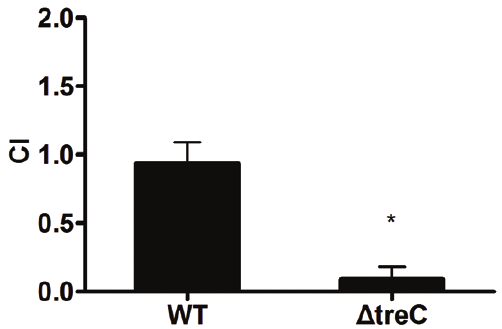
Figure 9. The in vivo competitiveness of D treC . Groups of 6 BALB/ c mice were fed with 2 6 10 6 K. pneumoniae . ( D p lacZ strain mixed with the wild-type strain or the D treC strain, the ratio was 1: 1). The bacteria were harvested from colon when mice were euthanized on the 7 th day after infection and plated onto LB plates. The ratio of lacZ -negative colonies to lacZ -positive colonized was determined. Competition index of D treC group vs D p lacZ mutant group, 0.083 6 0.25, * p =0.0039.